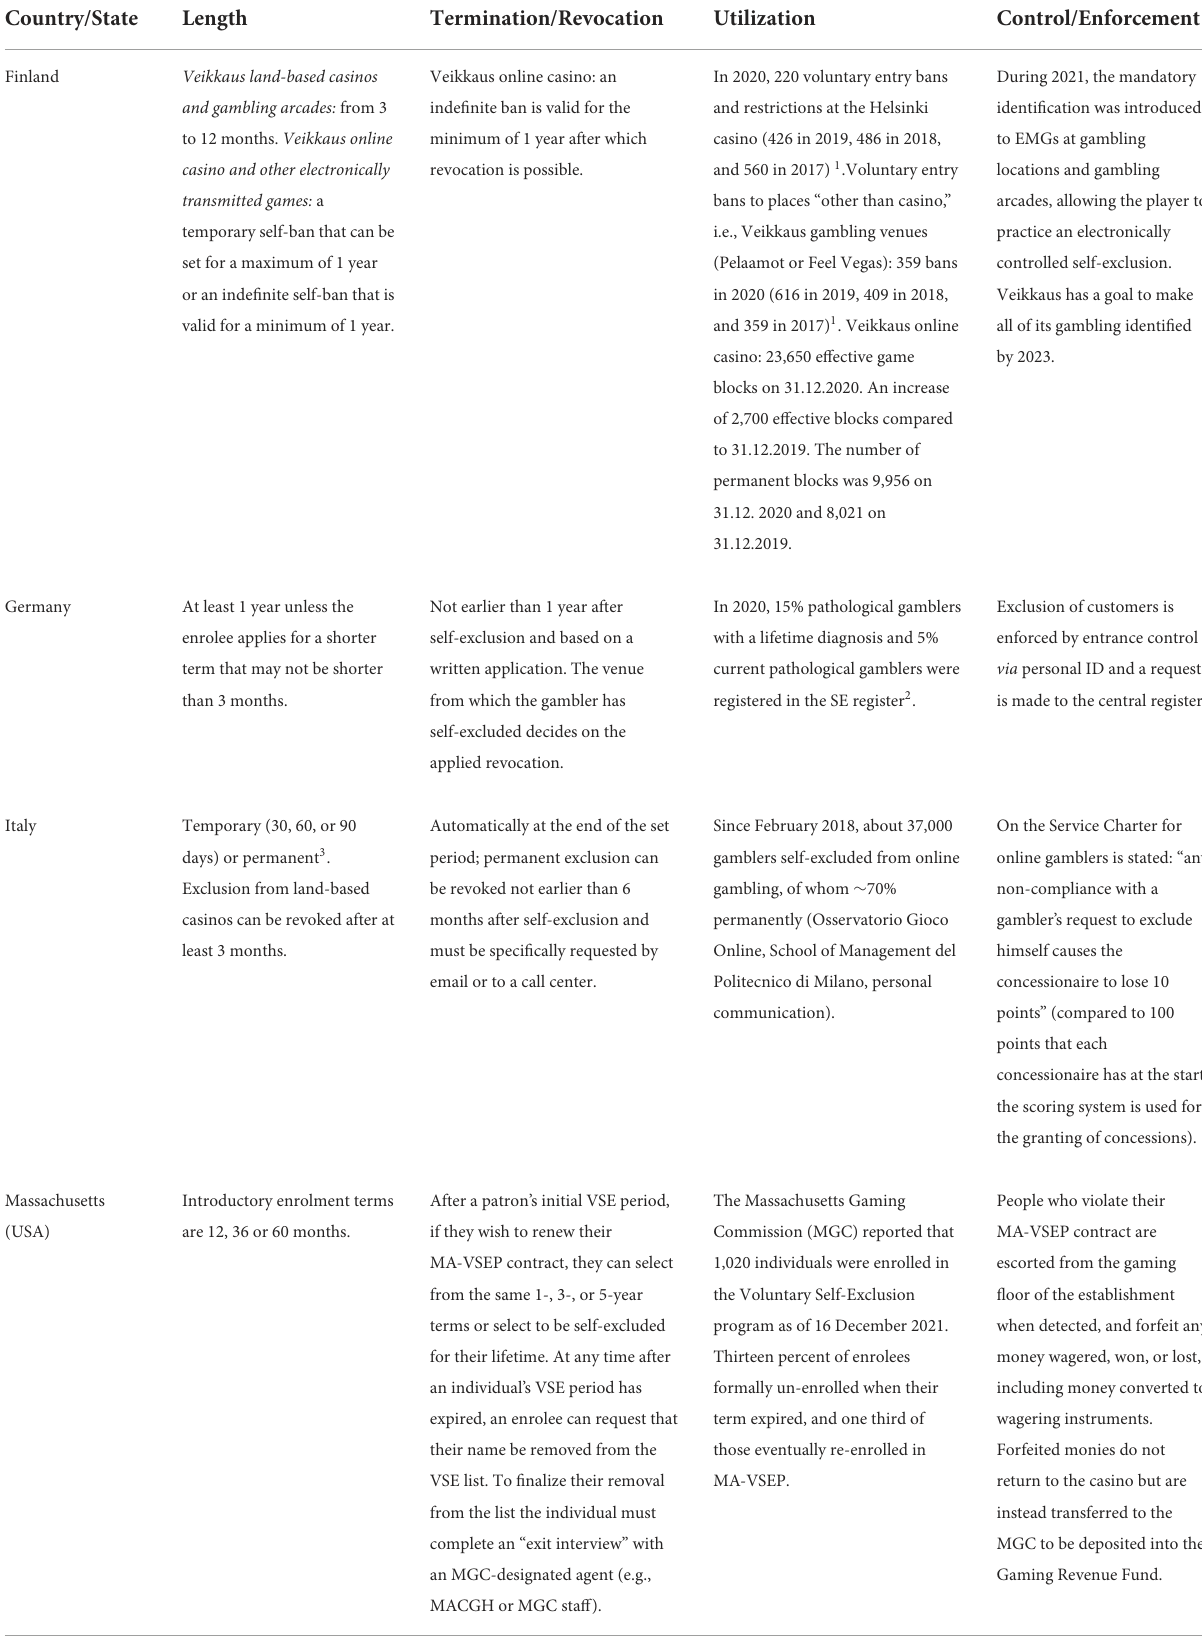
TABLE 3 Summary of voluntary self-exclusion regulations (length, termination/revocation, utilization, control/enforcement by country/state.